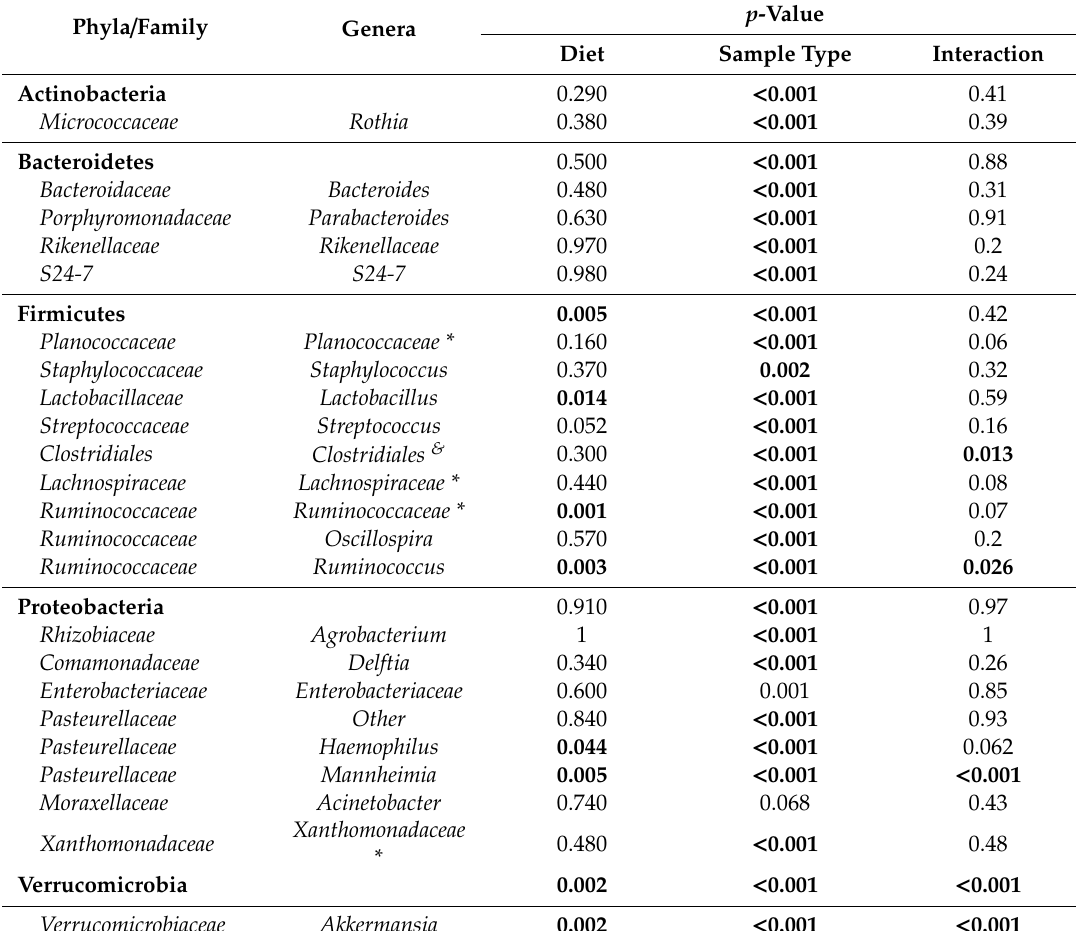
Table 2. Statistical comparisons of predominant bacterial phyla, families, and genera in maternal ceca, milk, and o ff spring ceca of rat dams fed a 10% protein (LP) or 20% protein (HP) diet. p -values were generated using general linear models